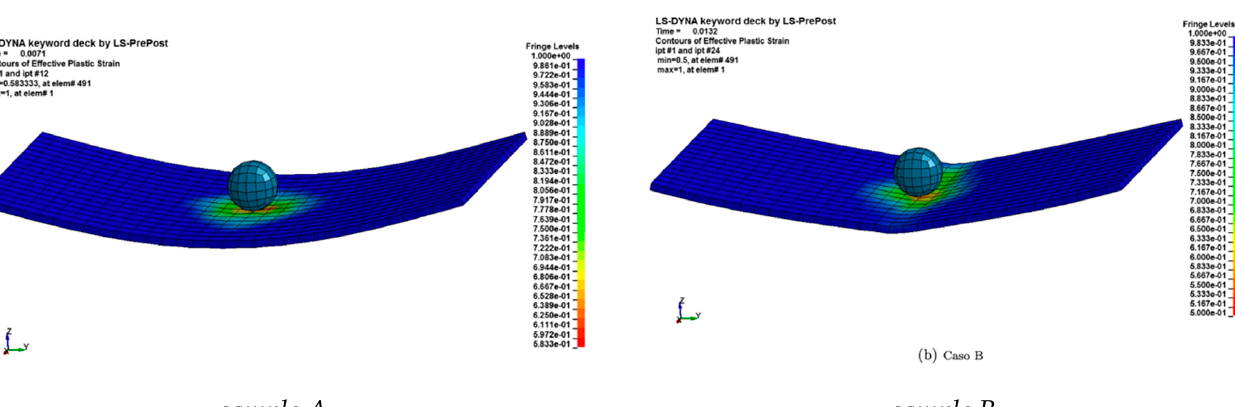
Figure 7. Maximum displacement for the plate during the impact evolution.